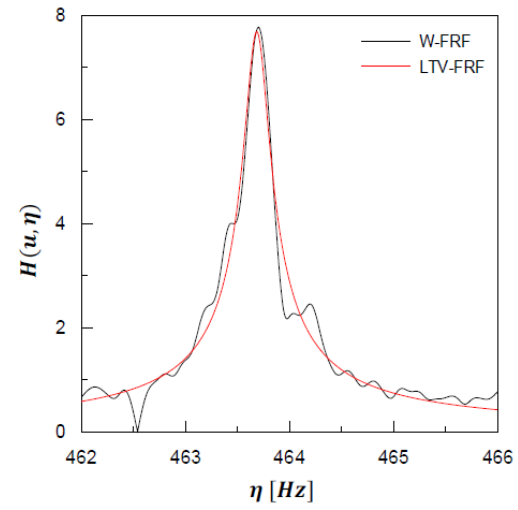
Figure 10. LTV-FRF best fitting of